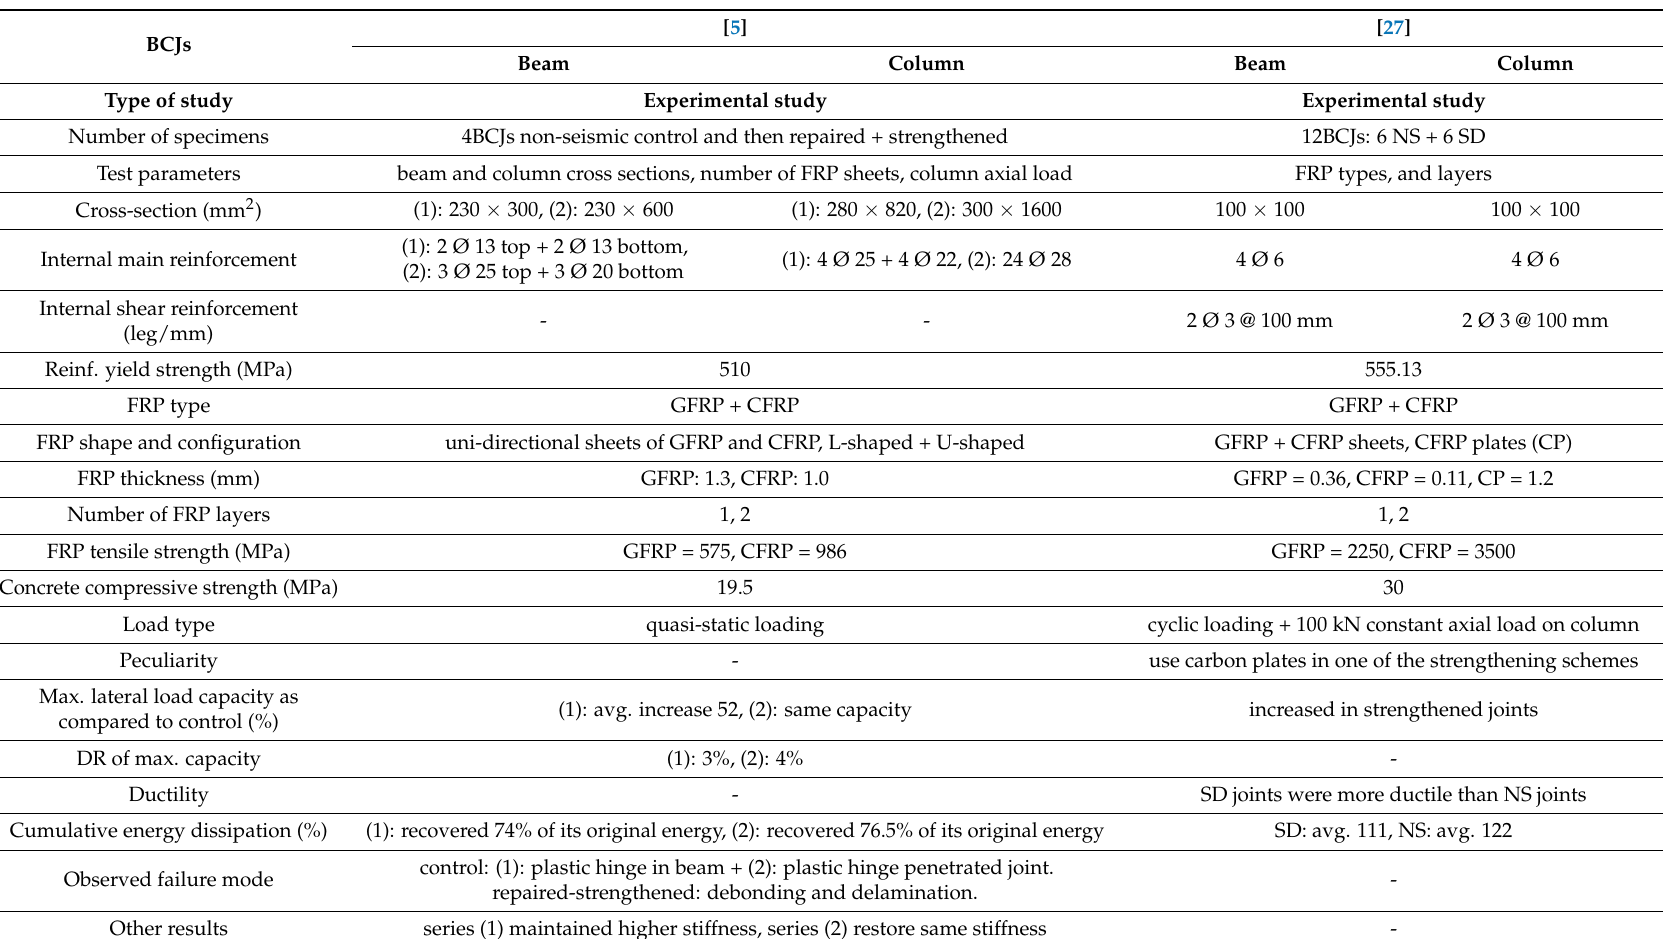
Table 5. Summary of experimental work on BCJs externally reinforced with more than one FRP types (CFRP, GFRP). BCJs